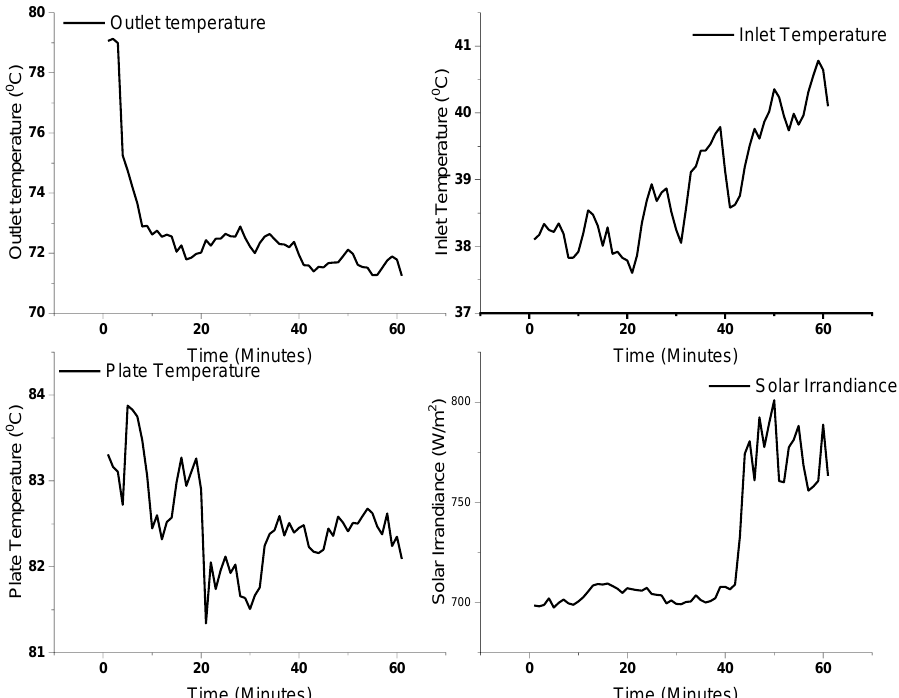
Figure 12. Graphical representation of the different temperatures and solar irradiance as function of time during the final experiment.